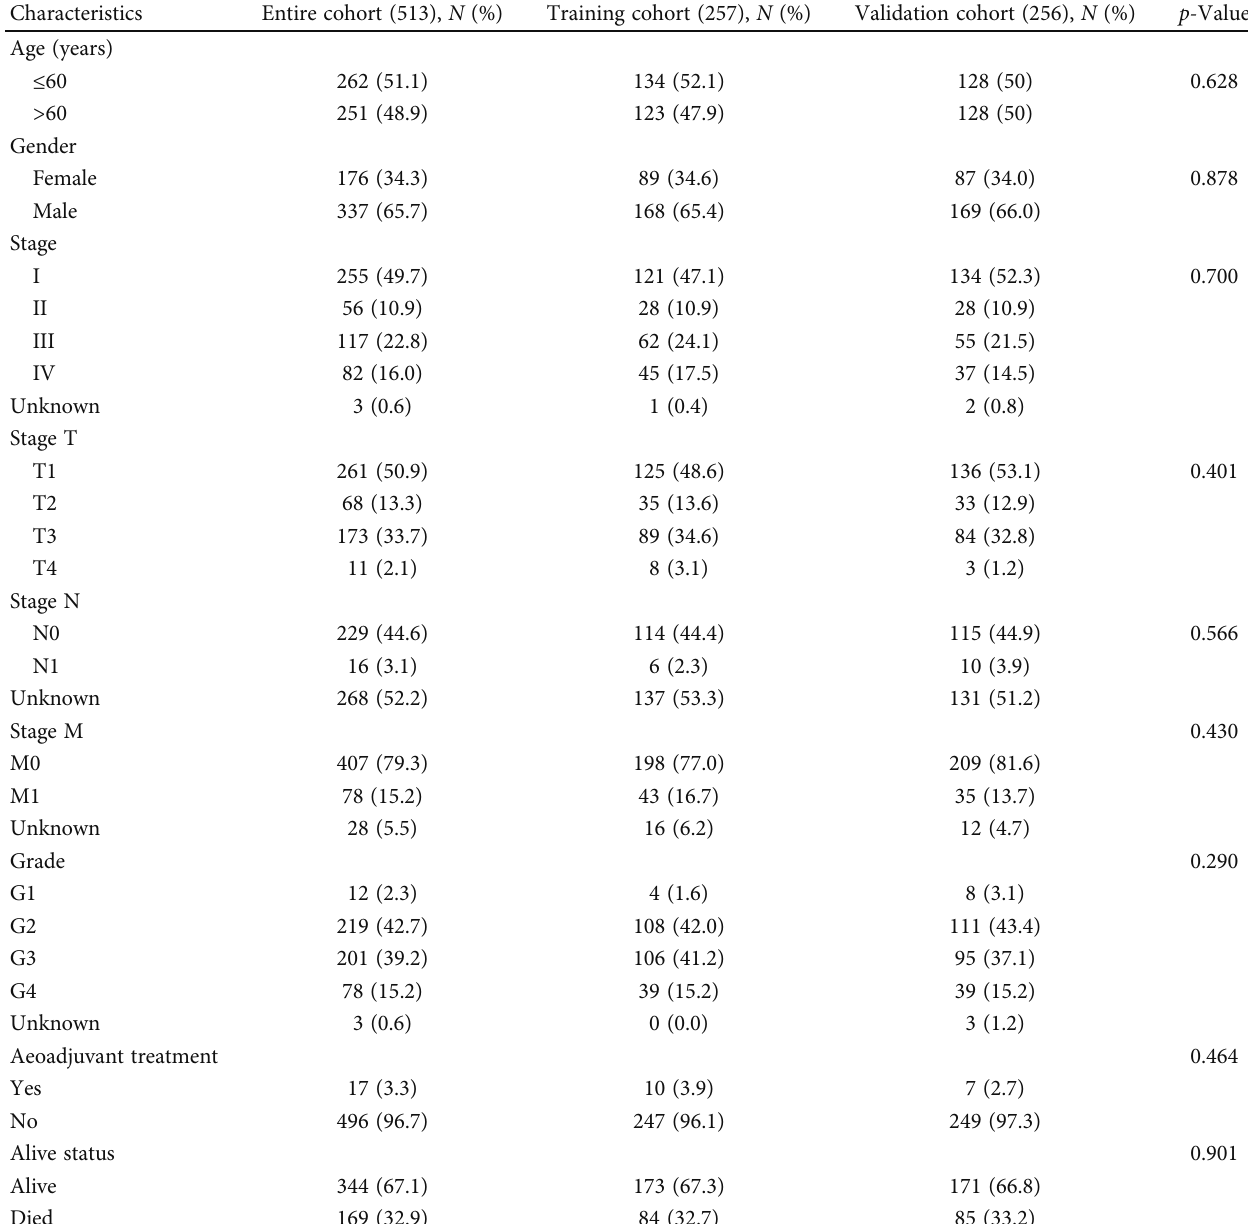
Table 1: Characteristics of clear cell renal cell carcinoma